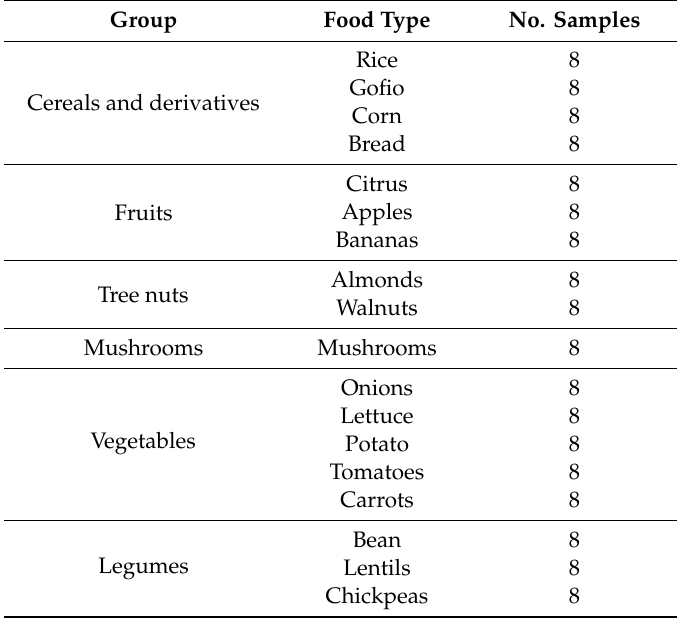
Table 1. The number of analyzed samples according to the type of